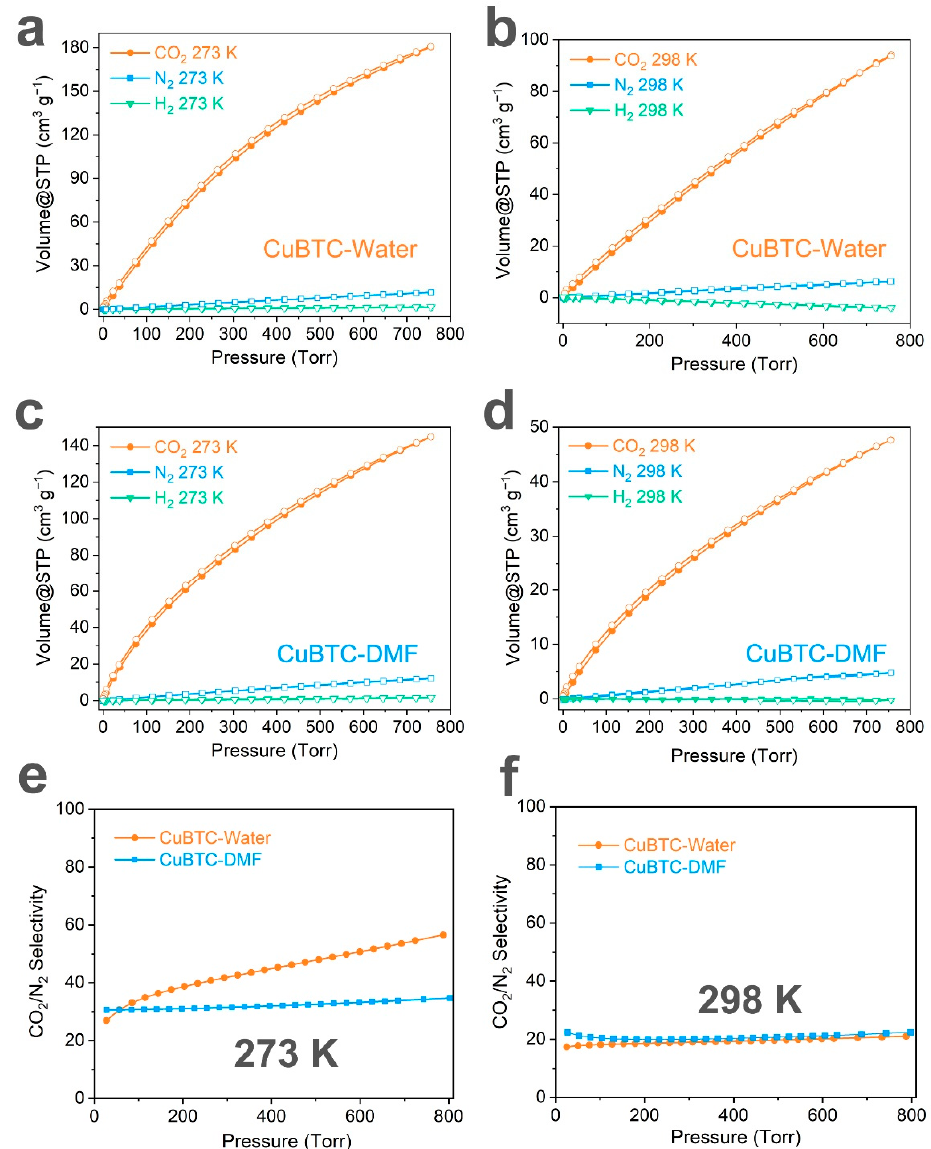
Figure 3. ( a , b ) Adsorption–desorption isotherms of CuBTC-Water at 273 K and 298 K. ( c , d ) Adsorption–desorption isotherms of CuBTC-DMF at 273 K and 298 K. ( e , f ) Selectivity of CuBTC-Water and CuBTC-DMF for CO 2 /N 2 mixtures (CO 2 /N 2 = 15:85 v / v , calculated using the IAST method) at 273 K and 298 K.